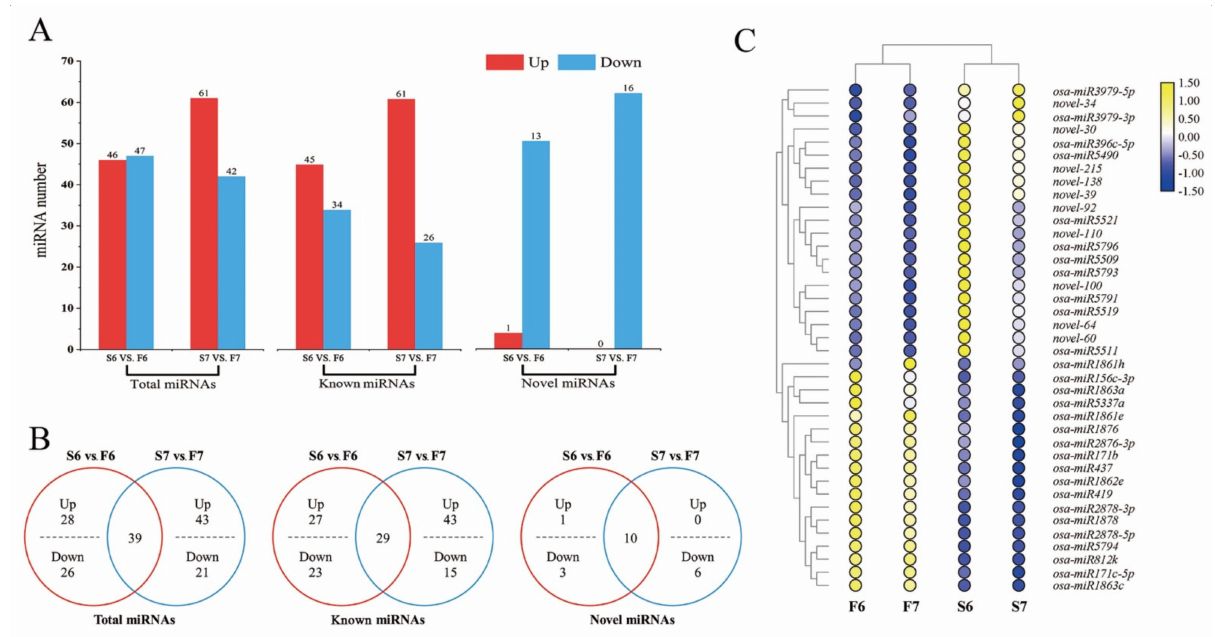
Figure 3. Differentially expressed miRNAs in PA64S(S) and PA64S(F). ( A ) The number of miRNAs up- or downregulated in stages 6 and 7. ( p < 0.05) ( B ) Venn diagrams showing the unique and shared differentially expressed miRNAs in stages 6 and 7. ( C ) Hierarchical cluster analysis of 39 differentially expressed miRNAs in stages 6 and 7. The relative expression levels in the figure are the average of three